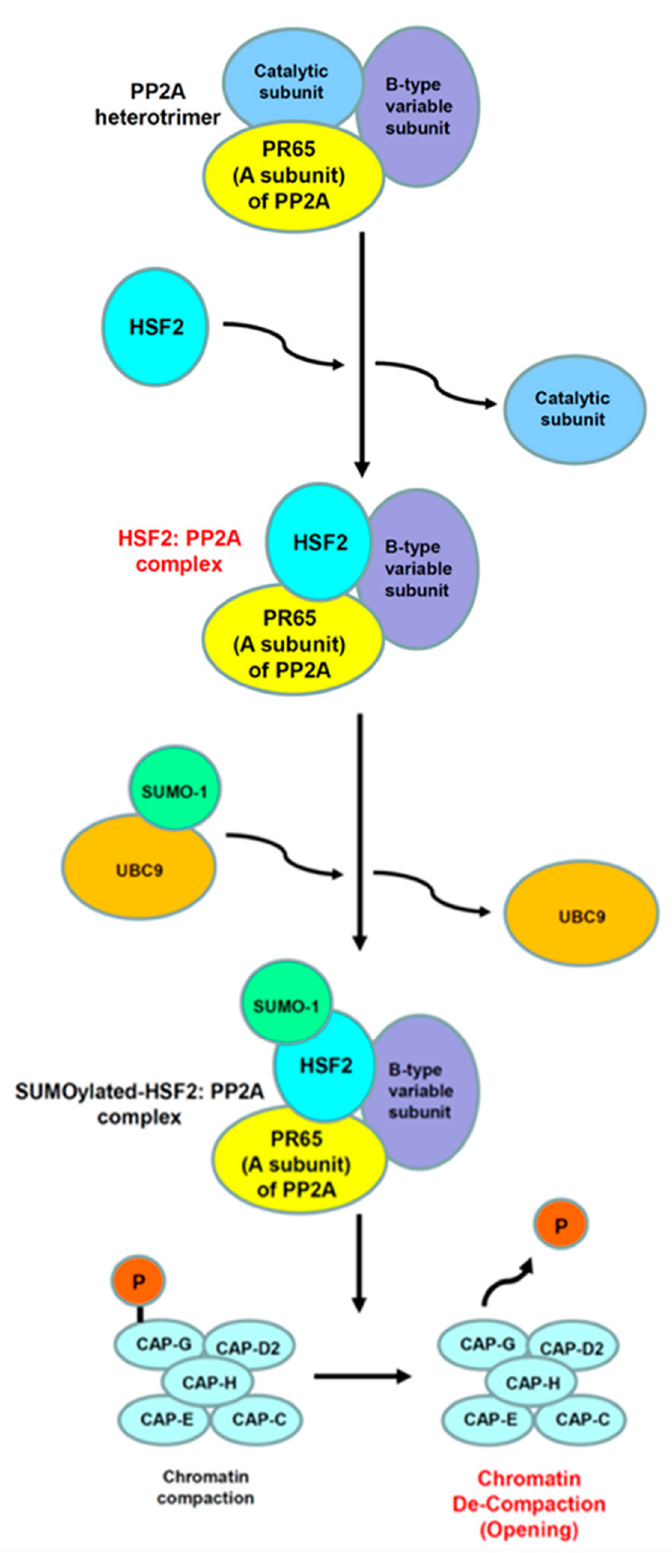
Figure 2. Simplified model of gene bookmarking by HSF2. This model is established on the HSP70 promoter [182]. However, this model probably comes into existence on other promoters.